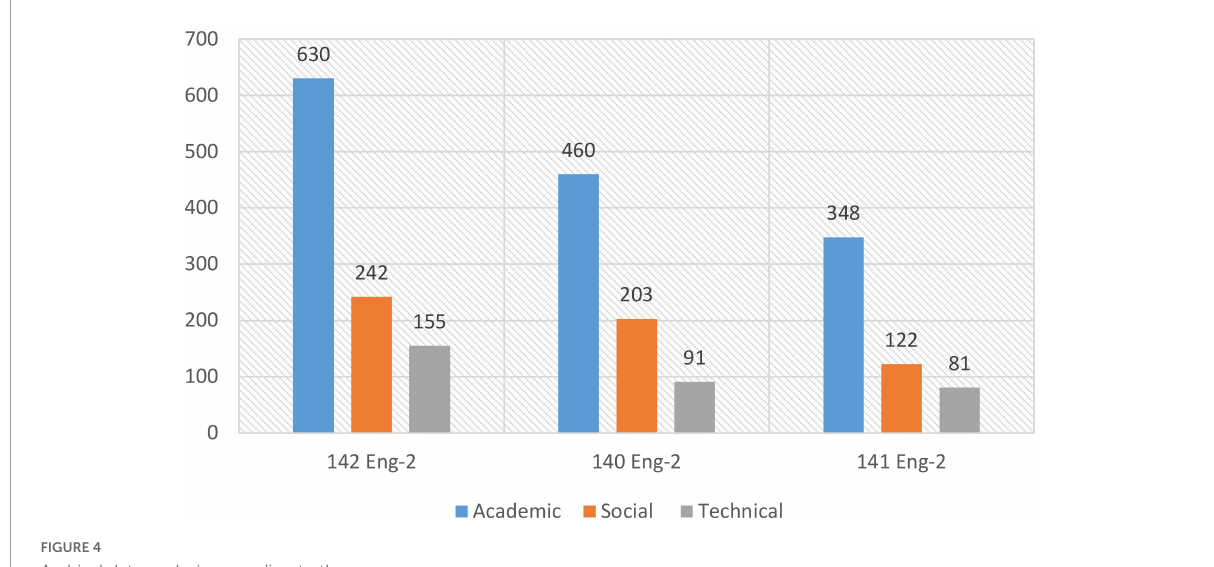
FIGURE4 Archival data analysis according to the